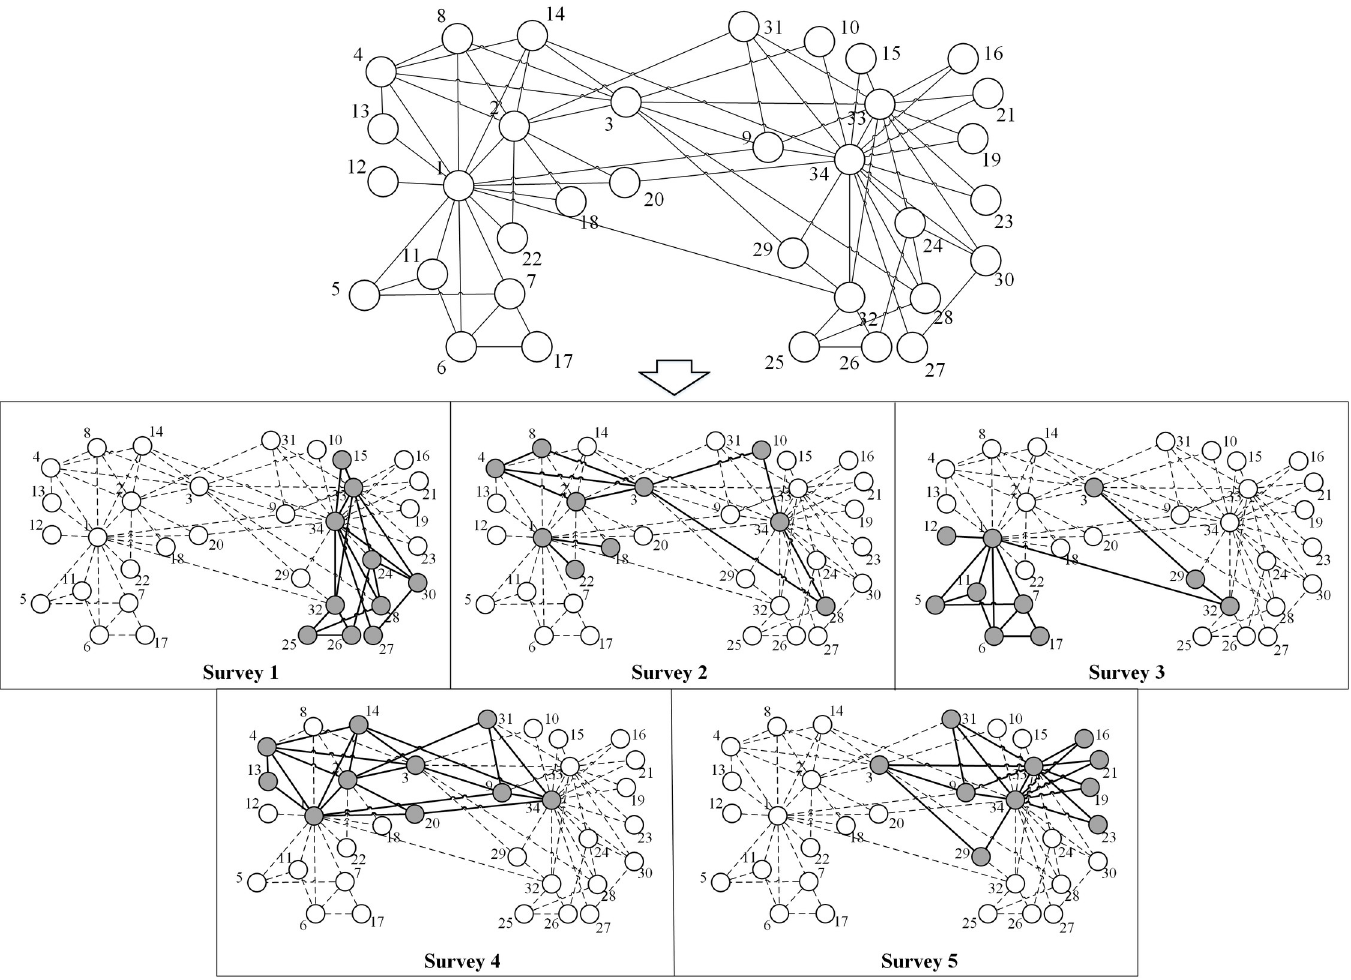
Fig 14. The sampling solution of Zachary’s Karate Club network with k = 0.3 N and m = 5. The upper part is the topology of Zachary’s Karate Club network. The lower part is the solution of extracting multiple subgraphs. In the solution part, grey nodes represent included nodes and white nodes represent omitted nodes. The dashed lines represent the unobserved ties, while the bold solid lines represent the extracted